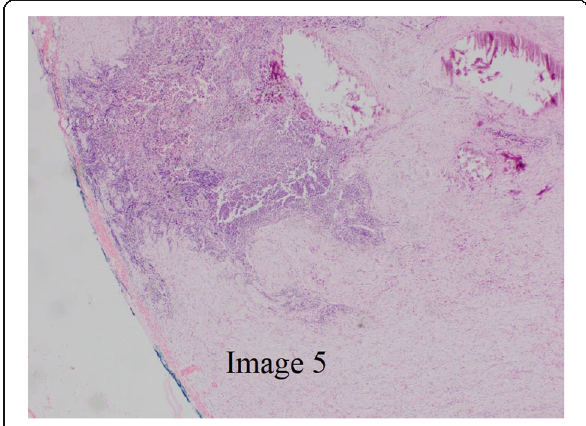
Fig. 5 Hematoxylin and eosin stain of the lymph node showing lymphoid tissue, calcified foci, and ganglioneuromatous